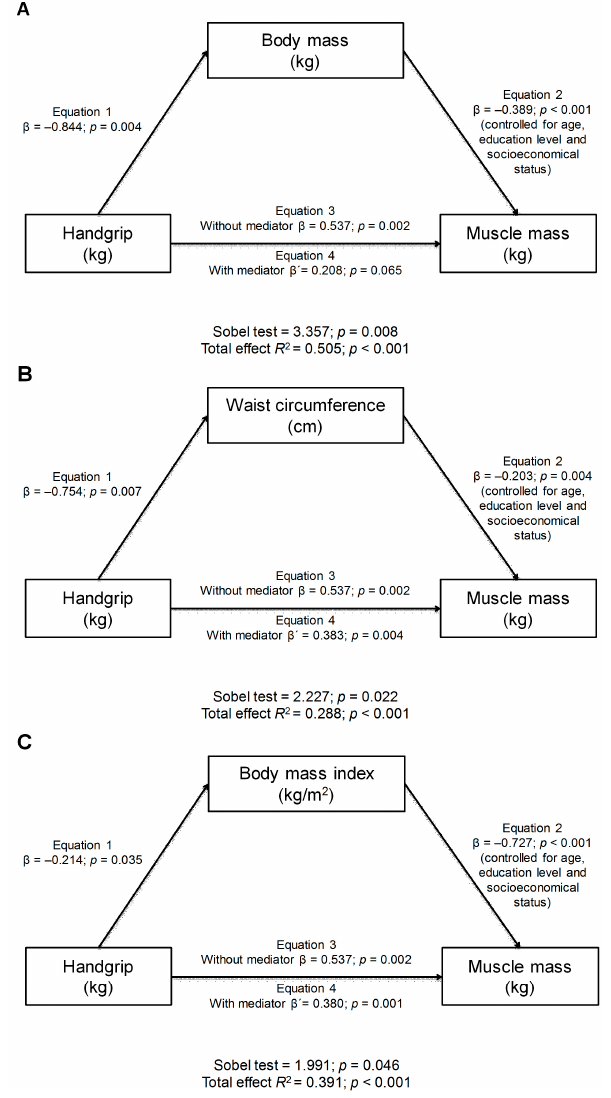
Figure 1. Anthropometric mediation models of the relationship between handgrip strength and muscle mass, adjusted by age, education level, and socioeconomic status. ( A ): body mass; ( B ): waist circumference; (C): body mass index; β : unstandardized regression coefficient